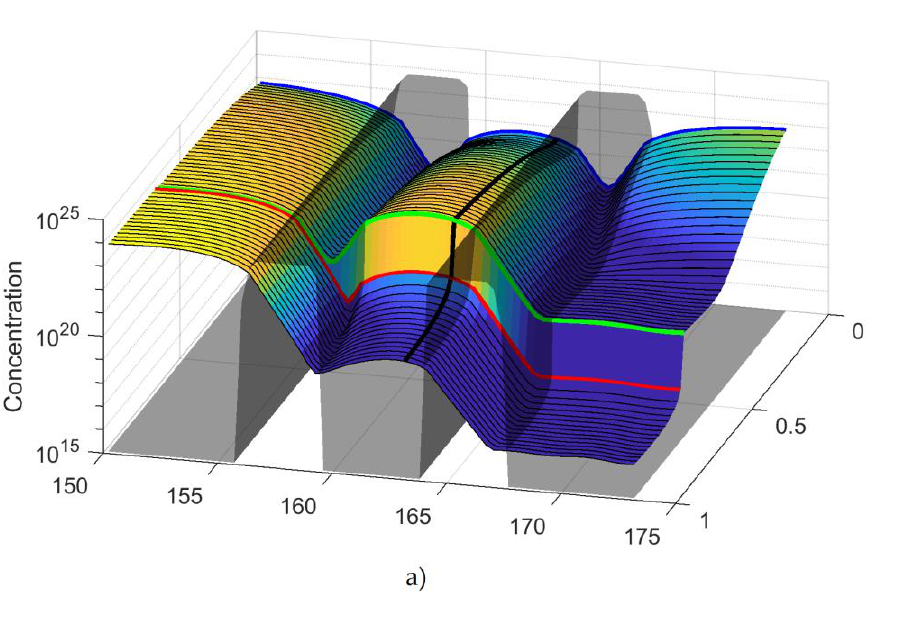
Figure 2. ( a ) Electron concentration (translucent surface — potential energy of electron without self- consistency); ( b ) self-consistent potential; ( c ) local density of states (dashed lines — bottom of con- duction zone at source).